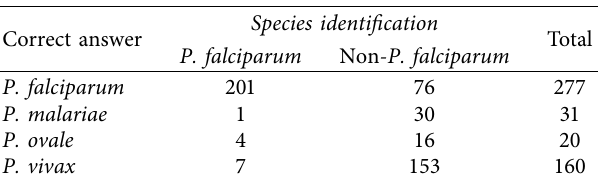
Table 8: Identification of P. falciparum or not among the Plas- modium -positive slides correctly in the qualitative microscopy by county-level representatives from medical